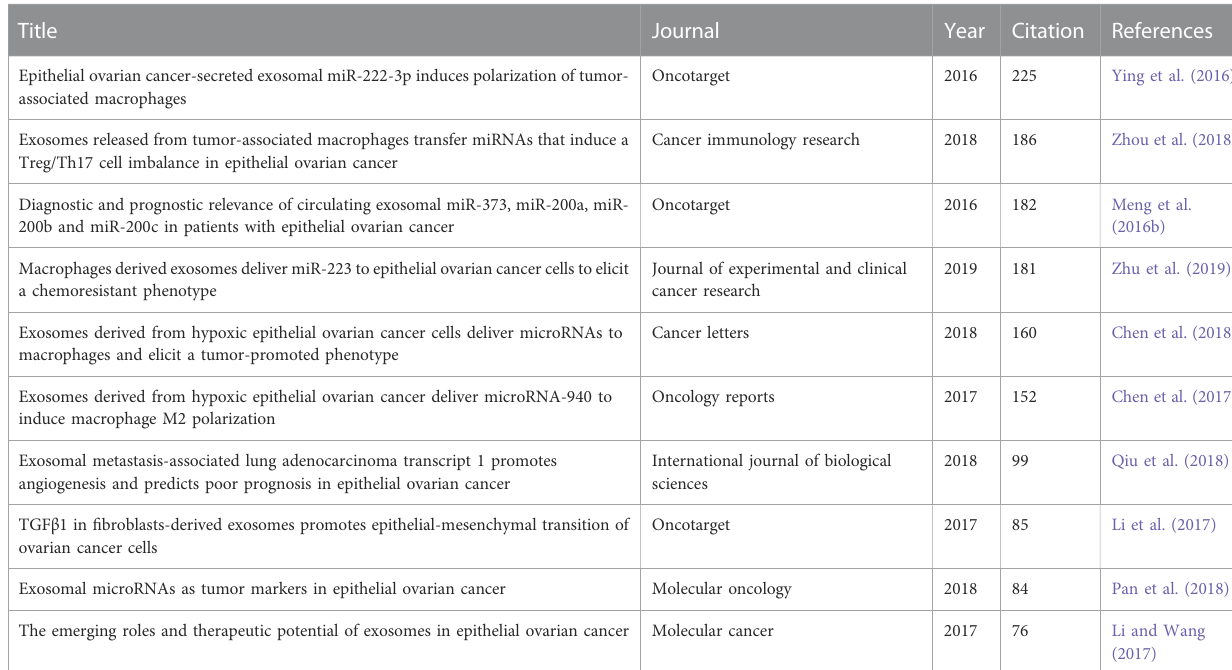
TABLE 3 The most cited articles in the fi eld of exosome and